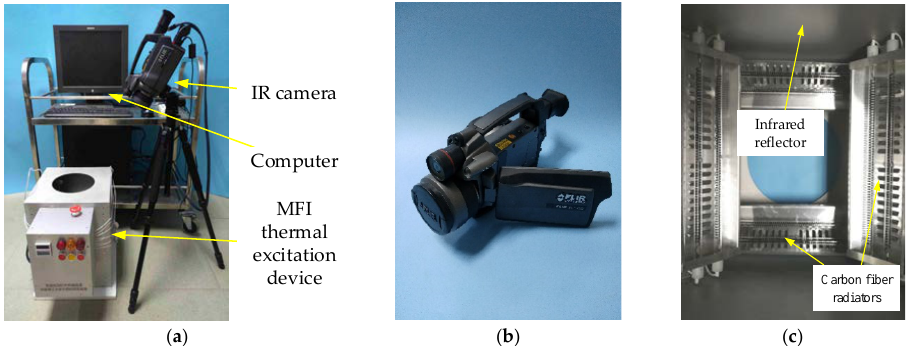
Figure 11. Active thermal sensing platform of glass curtain wall bonding structure damage detection. ( a ) Complete platform; ( b ) thermal imager; ( c ) crossed distribution of carbon fiber radiators.